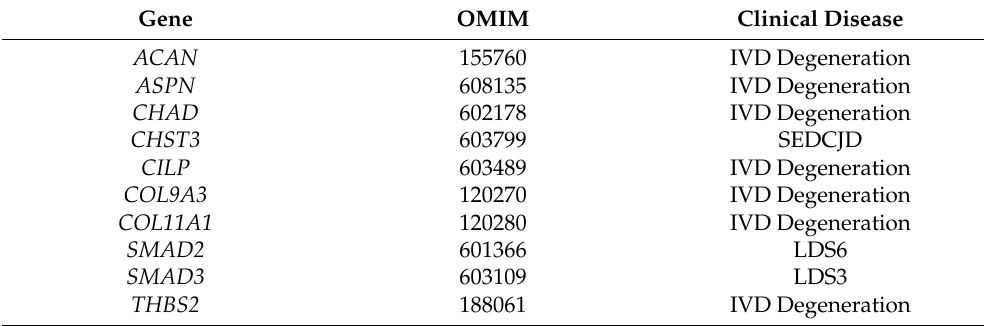
Table 1. Known genetic mutations that are associated with lumbar disc disease. We searched the OMIM Database for genetic variants that are associated with intervertebral disc